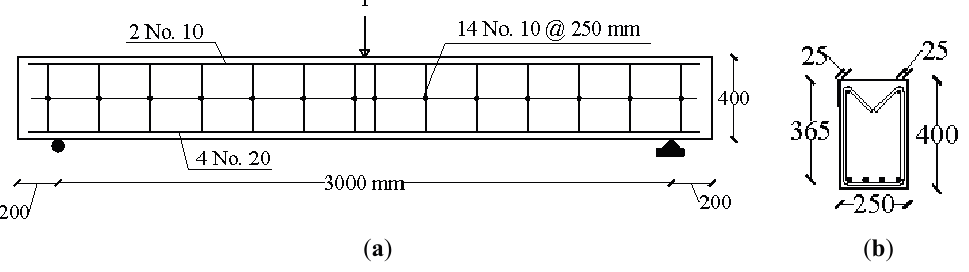
Figure 2. Typical beam dimensions, reinforcement and load configuration. ( a ) elevation; ( b ) cross-Section.